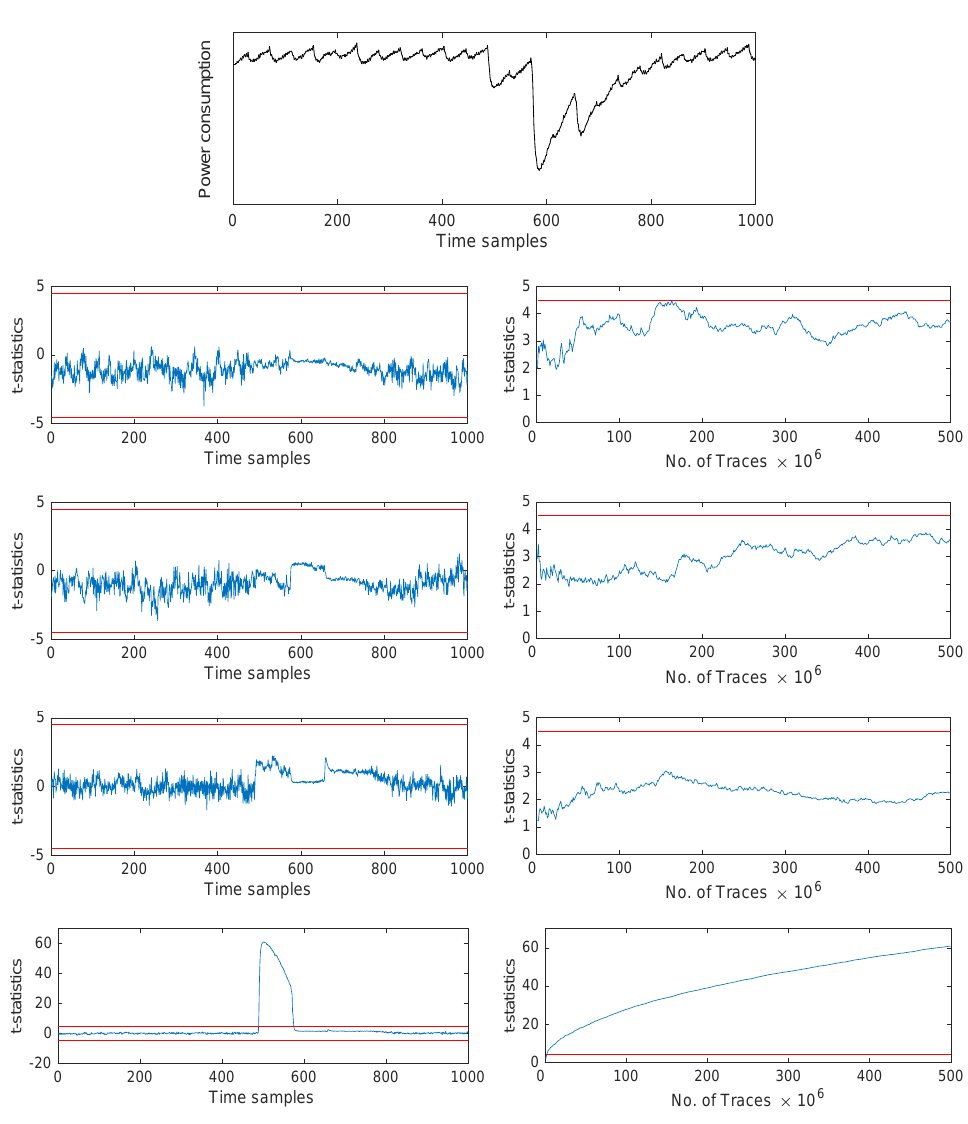
Figure 8: Sample power trace and univariate non-specific t -test results with 500 million measurements for a single DOM- dep multiplier with d = 3, based on GF (2 4 ) multiplications. The second to fifth rows show the t -statistics for statistical moments 1 to